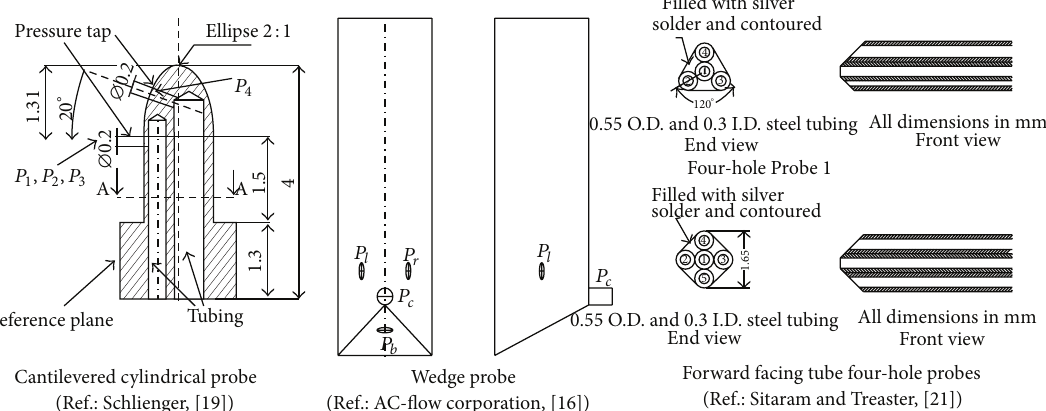
Figure 1: Commonly used four-hole probe